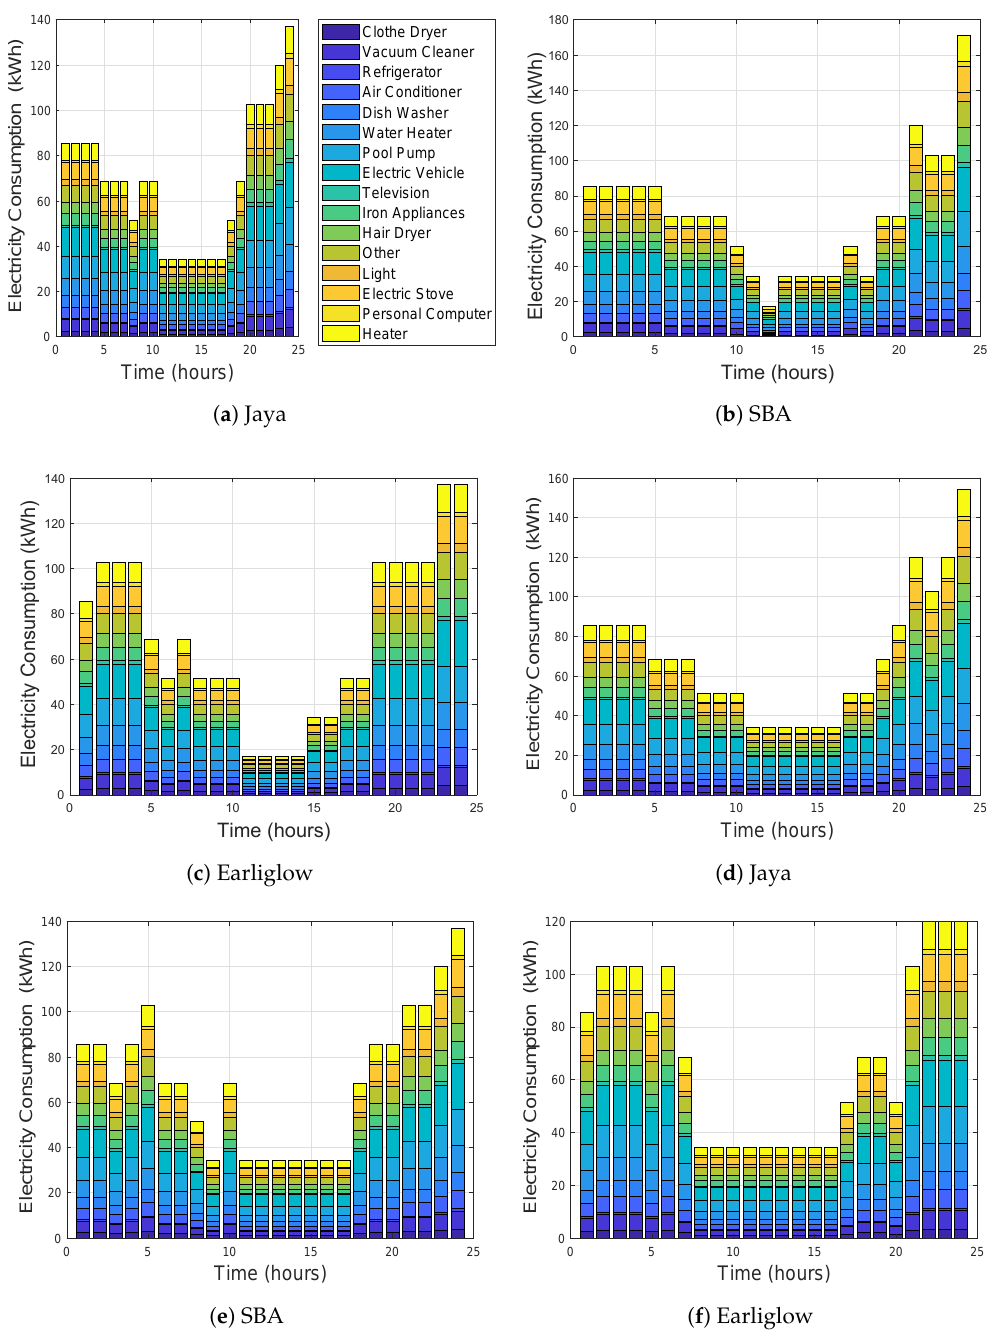
Figure 8. Hourly electricity consumption for each appliance with HEM. ( a ) hourly electricity consumption for each appliance with HEM for Jaya using CPP; ( b ) hourly electricity consumption for each appliance with HEM for SBA using CPP; ( c ) hourly electricity consumption for each appliance with HEM for Earliglow using CPP; ( d ) hourly electricity consumption for each appliance with HEM for Jaya using ToU; ( e ) hourly electricity consumption for each appliance with HEM for SBA using ToU; ( f ) hourly electricity consumption for each appliance with HEM for Earliglow using ToU. Using the ToU scheme: in Figure 8d, more appliances are shifted to the h 2 − 10 and h 21 − 24 of the day for Jaya based HEMS than the rest hours. From these results, most of the high energy consuming loads are moved to off-peak from on-peak hours. This reduces the electricity cost and may generate